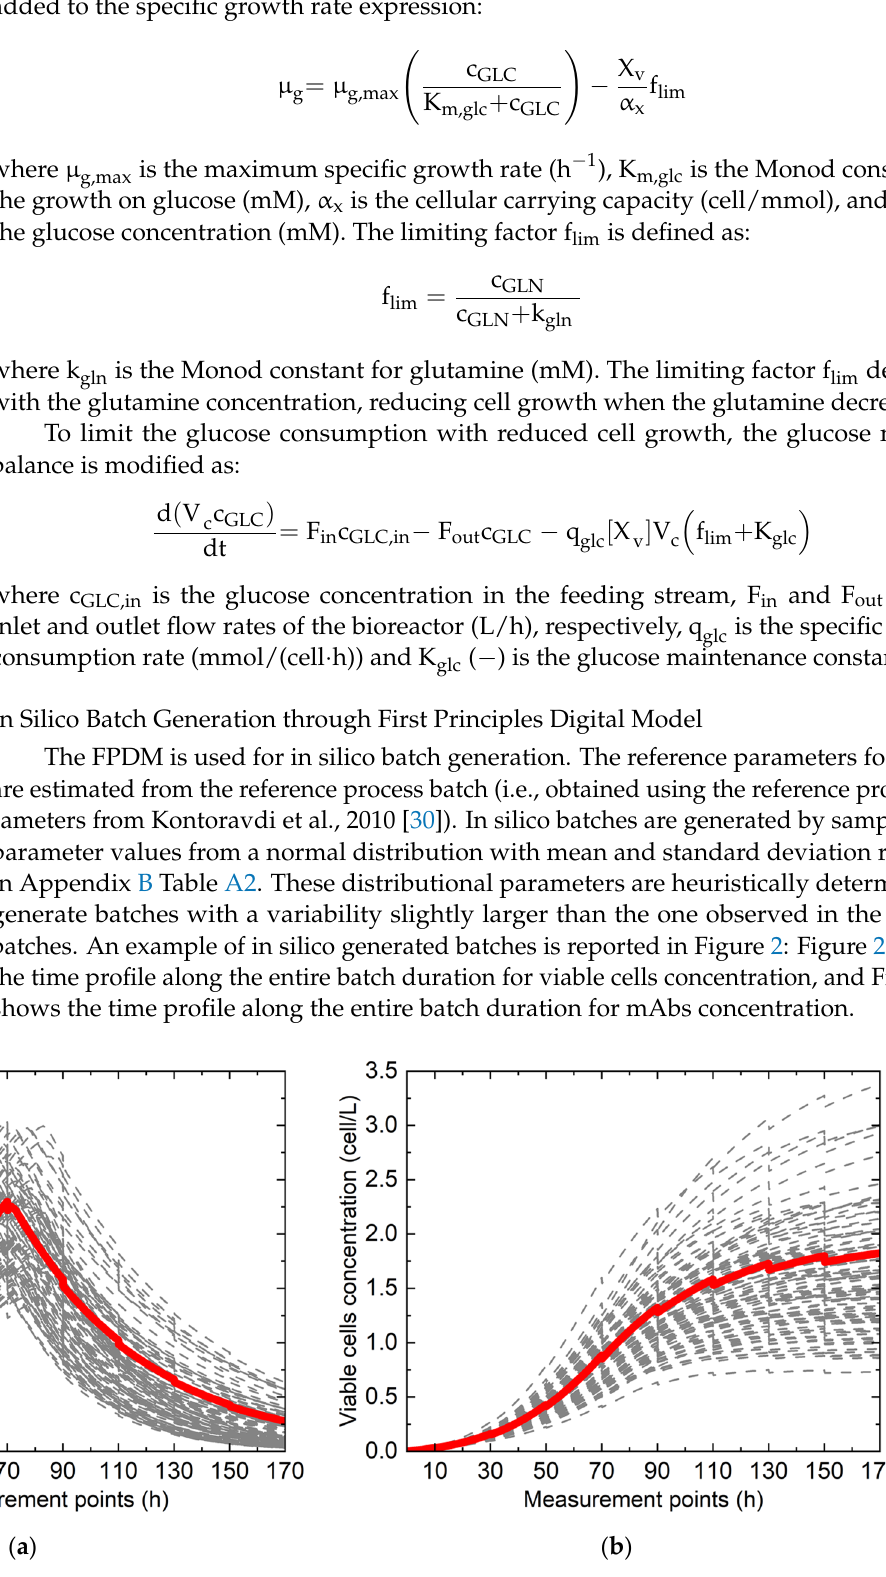
Figure 2. Example of batches generated in silico through the FPDM: ( a ) VCC profiles and ( b ) mAbs titer profiles for 100 batches. The thick red continuous lines represent the reference batch estimated from the process while the grey dashed lines represent the simulated ones.